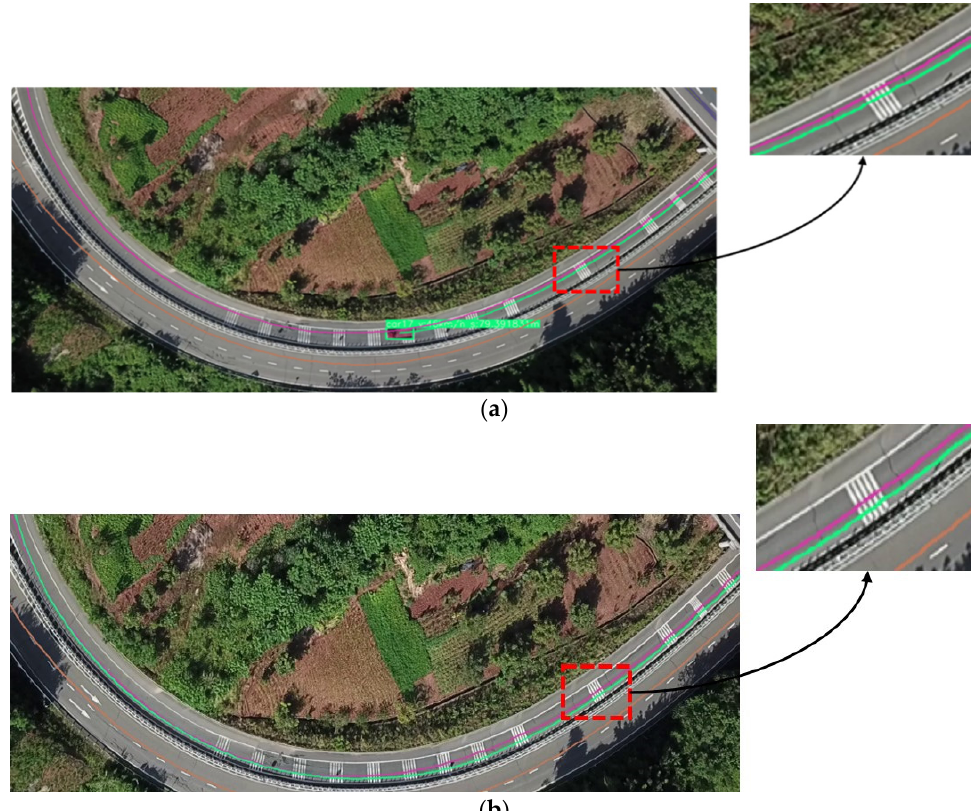
Figure 4. Camera wobbling issue: ( a ) vehicle trajectory at previous frame; ( b ) vehicle trajectory at a later frame.